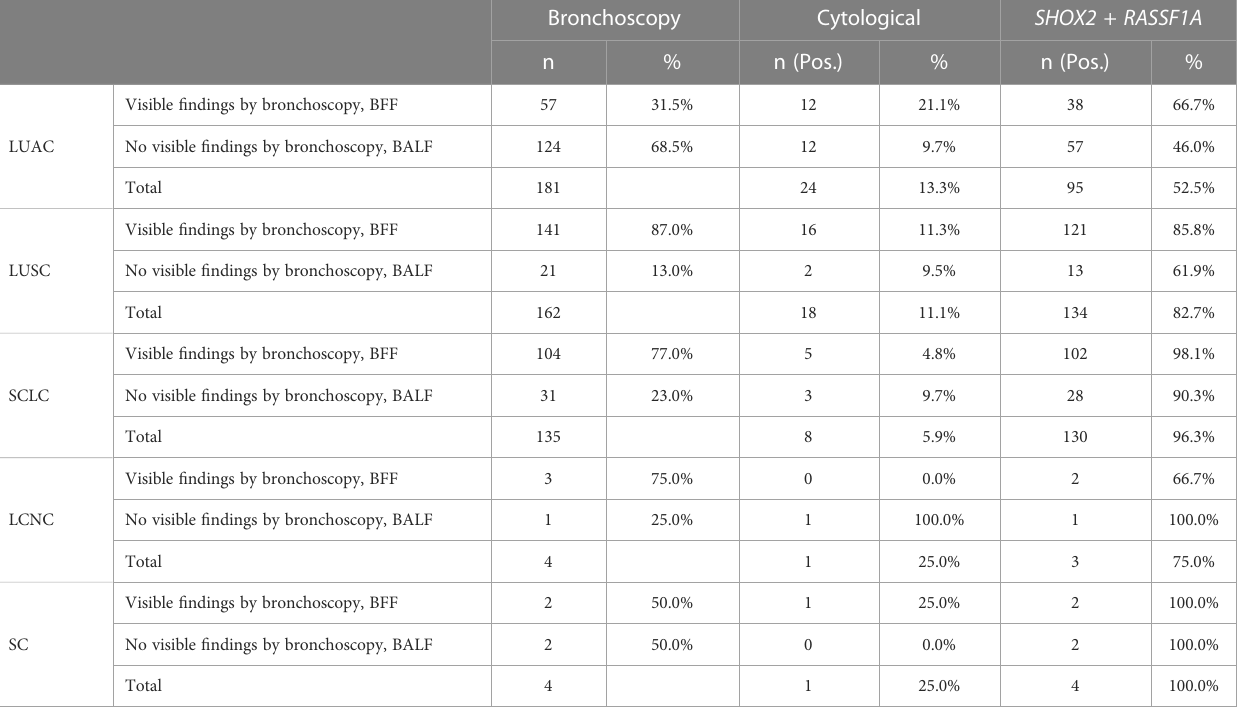
TABLE 2 Results of bronchoscopy in different histological subtype groups of lung cancer and sensitivity of DNA methylation in different types of each kind of histological subtype